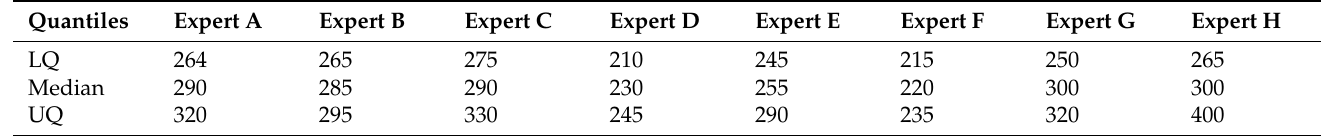
Table 3. Elicited quartiles for total GB electricity demand in 2030.